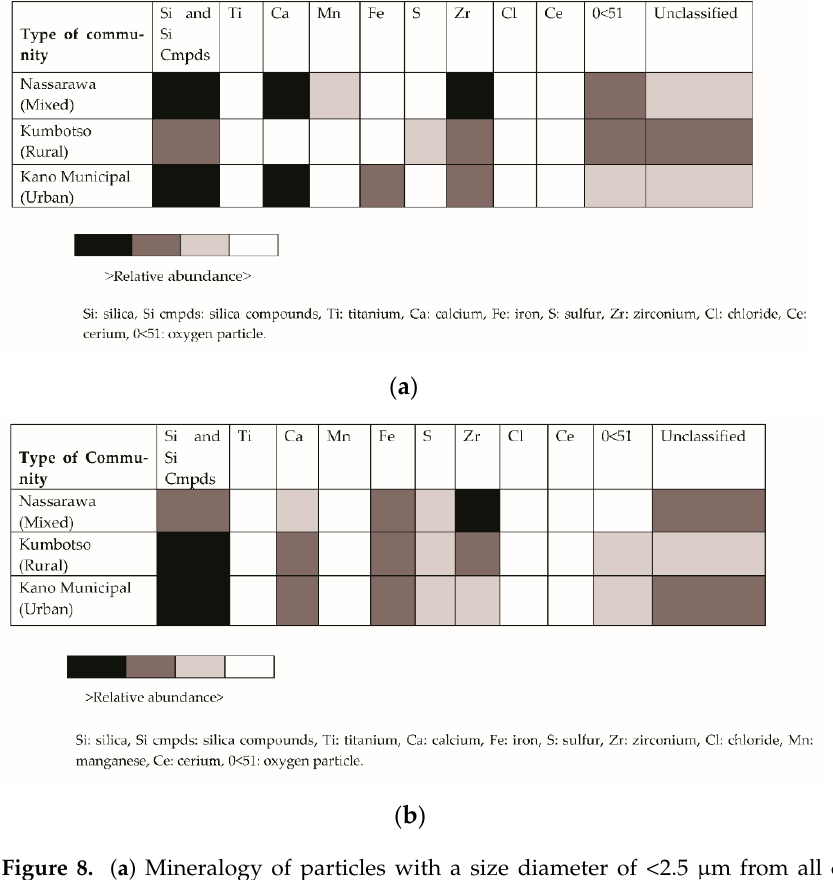
Table 2. Distances between households (HH) and air sampling sites in three local government areas in Kano State, Nigeria.